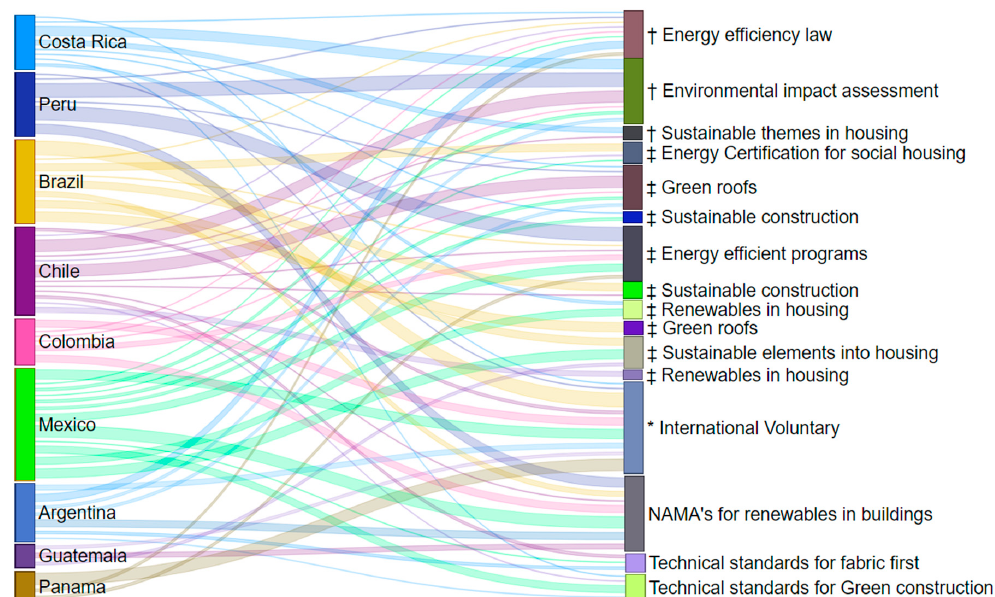
Figure 7. “Sankey” diagram that shows the situation of the green building regulations discussed in this article, (right side) and the corresponding country (left side) (legend = † command and control, ‡ economic incentives, * marketable permit system.